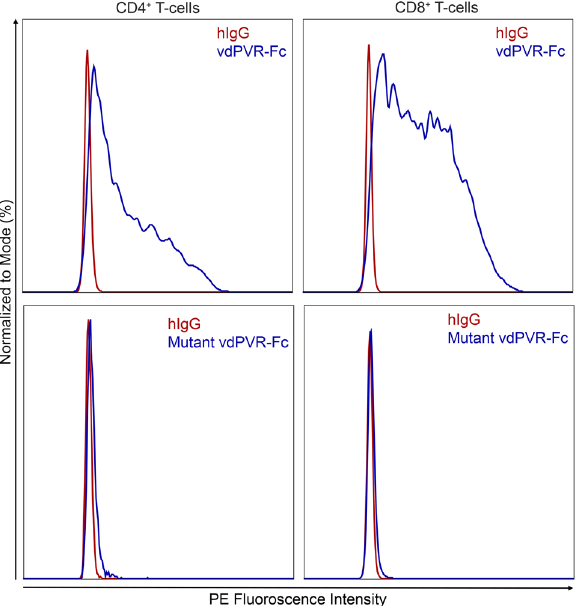
Figure 3. vdPVR-Fc binds to primary mouse T-cells. Stimulated T-cells in mixed splenocyte cultures were incubated with 2.5 µg of either vdPVR-Fc and mutant vdPVR-Fc. Histograms depicting vdPVR-Fc (blue) and mutant vdPVR-Fc (blue) binding to CD4 + and CD8 + T-cells compared with a human IgG1isotype control (red). Binding of vdPVR-Fc and mutant vdPVR-Fc to T-cells was detected with an anti-human IgG1 Fc antibody conjugated to PE. Data is representative of 2 independent